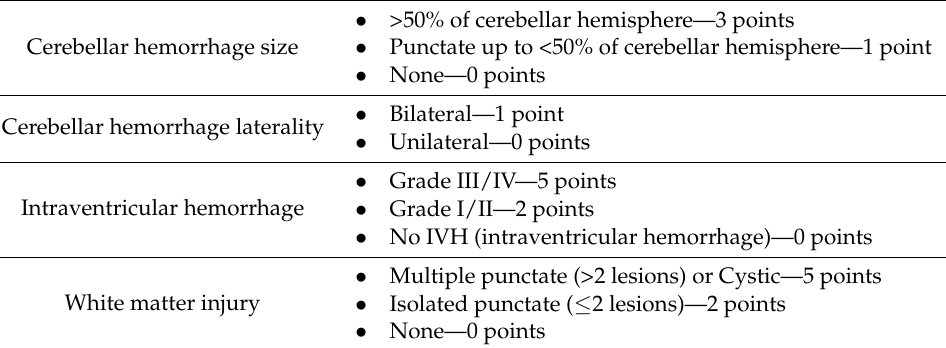
Table 1. MRI Scoring